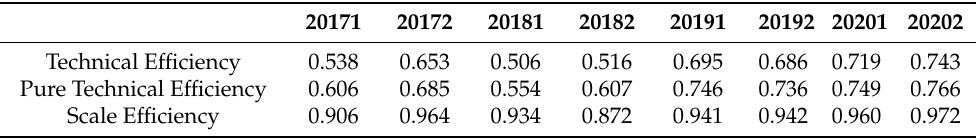
Table 6. Average of green financing efficiency in the third